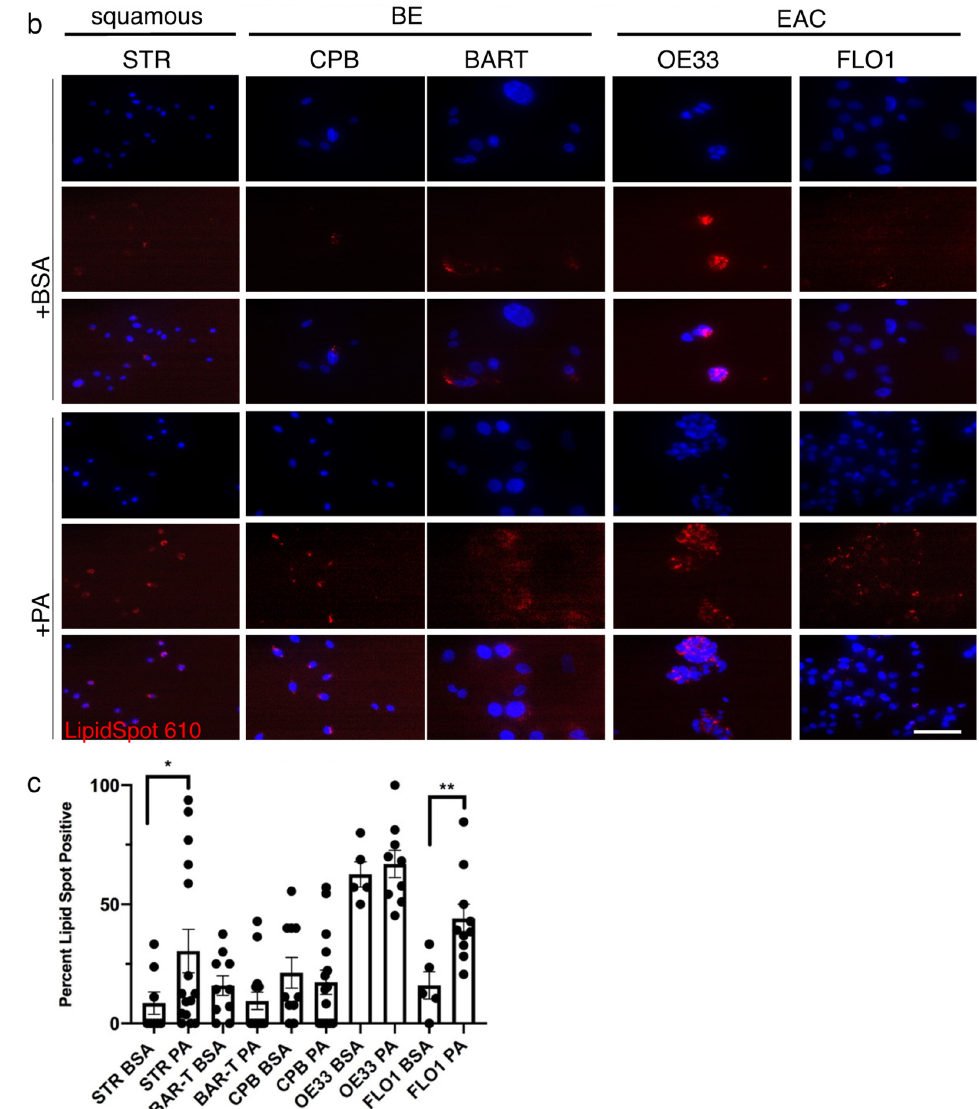
Figure 3. Palmitic acid uptake can be detected in esophageal epithelial cells. ( a ) The Oil Red O stain shows a general presence of lipids in STR, CPB and BAR-T cells as well as the EAC cell lines, OE33 and FLO1. ( b ) The fluorescent red signal using LipidSpot TM for the detection of neutral lipids is observed in the BE cell lines, CPB and BAR-T, and EAC cells, OE33 and FLO1 after treatment with 30 µ M palmitic acid for 90 min compared to BSA control, DAPI for nuclear stain. ( c ) Lipidspot-positive cells were counted per field and compared to total nuclei for quantification. * p < 0.05, ** p < 0.01, t -test with Welch’s